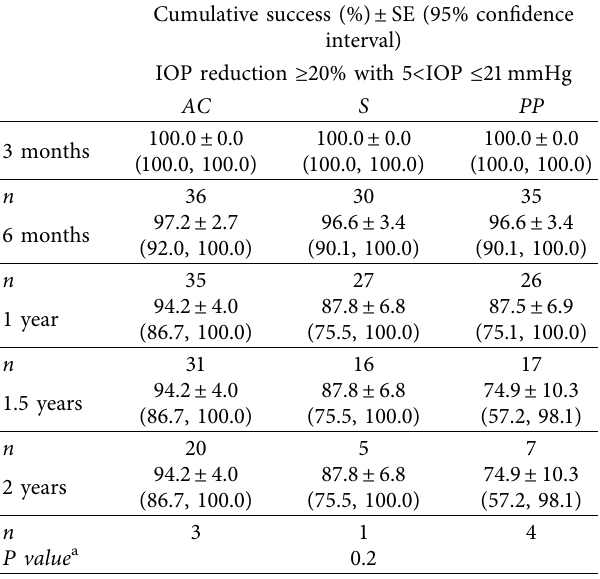
Figure 1: Line graphs of average values of postoperative (a) intraocular pressure, (b) number of medications, and (c) visual acuity over time. Error bars denote standard error of the mean. Table 6: Life